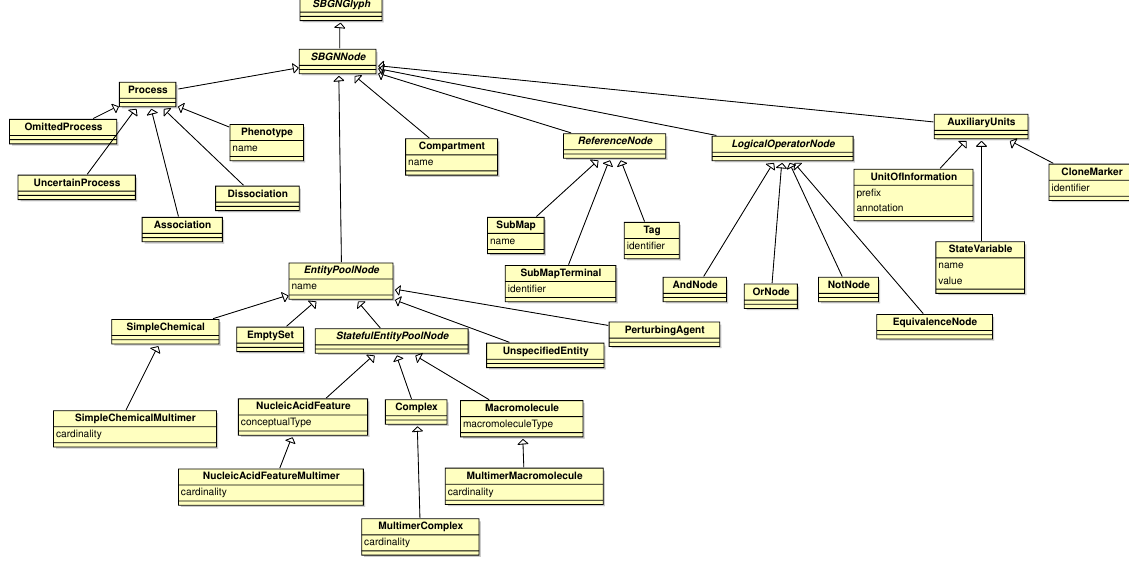
Figure 3.1: Organisation of the node glyphs within SBGN Process Description language. All UML classes (boxes) correspond to Process Description node glyphs except those with italicised names, which are organisational groupings. They correspond to the groupings used elsewhere in this document.